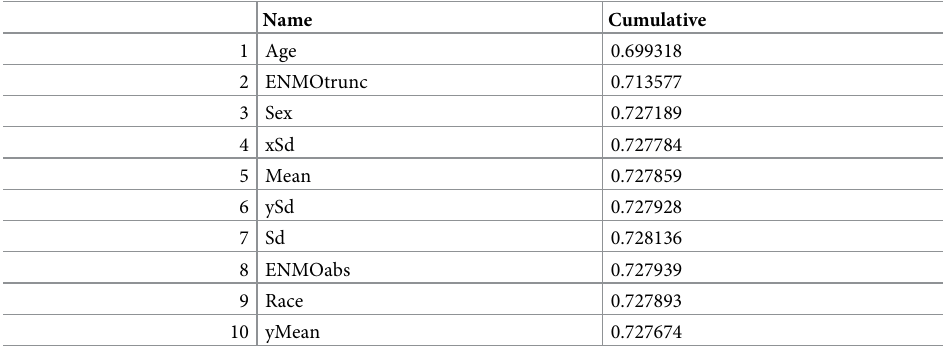
Table 4. Min Model sensor input only, with cumulative C-index